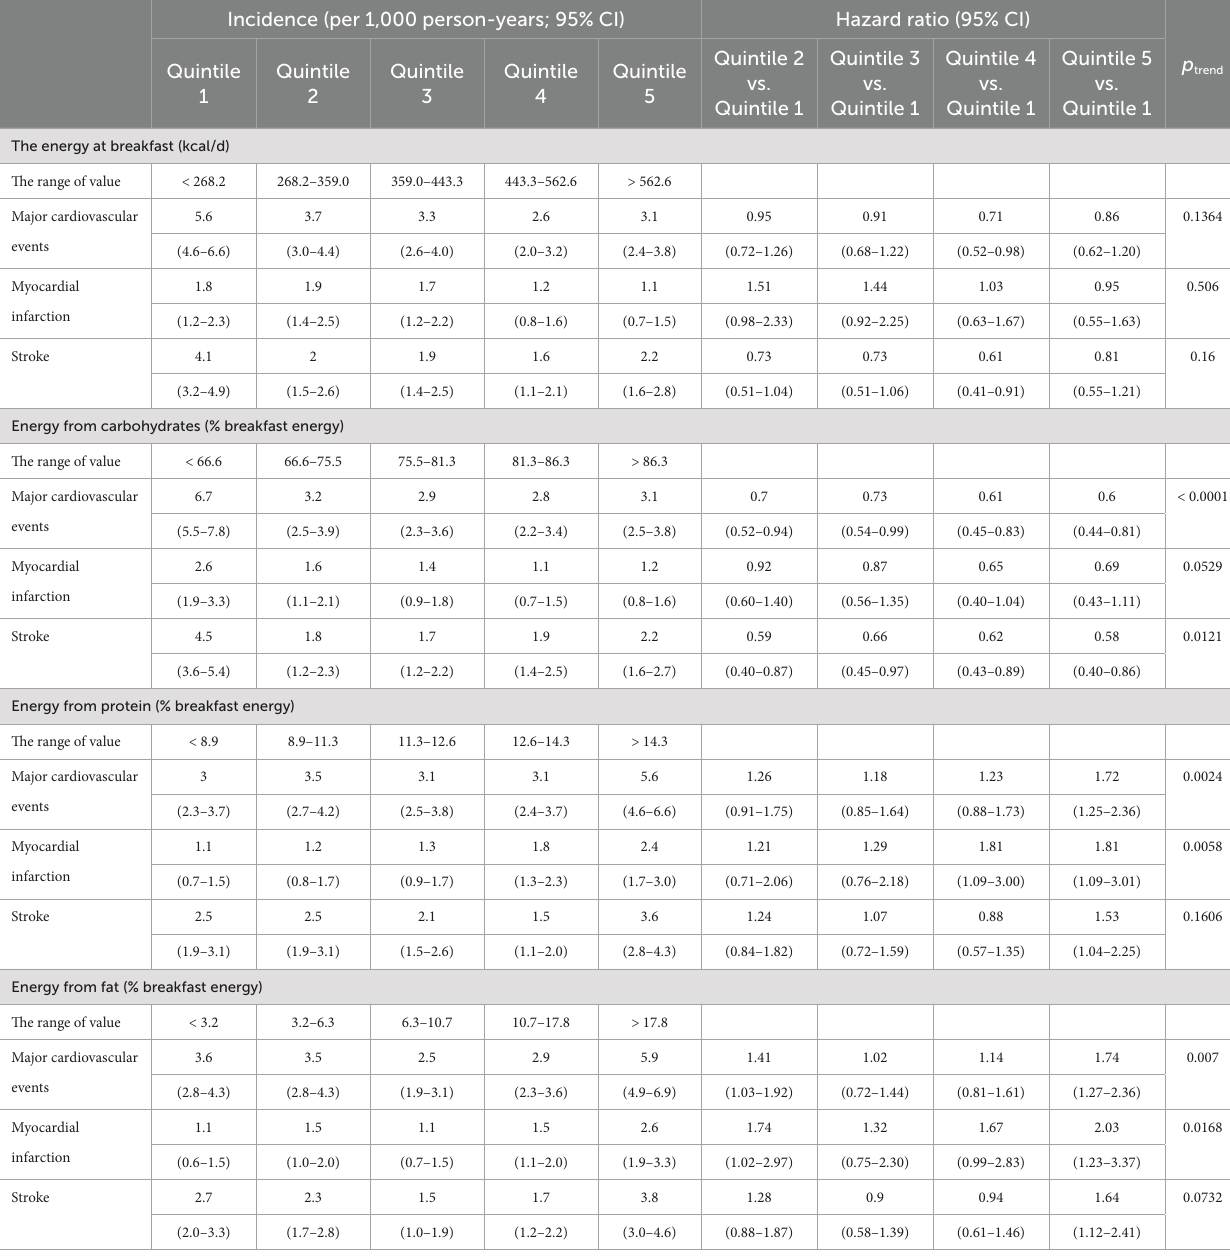
TABLE 2 Association between energy and percentage energy from macronutrients at breakfast and health